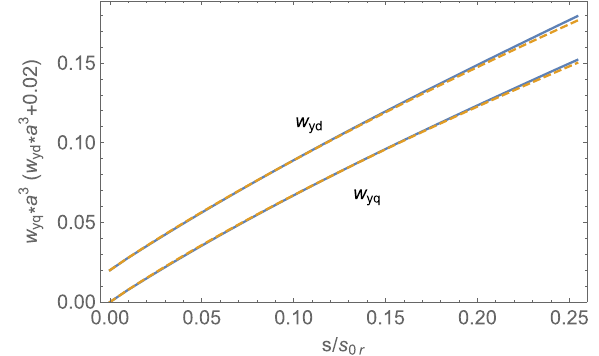
FIG. 7. Quad and dipole wakes on axis for the RadiaBeam/ LCLS dechirper nominal parameters, comparing the numerical inverse Fourier transform of the impedance equations, Eqs. (19), (24) (blue curves), with the approximations, Eqs. (22), (23), (27) a 3 have been shifted up (the dashes). Note that the curves for w yd by 0.02 units to improve visibility.